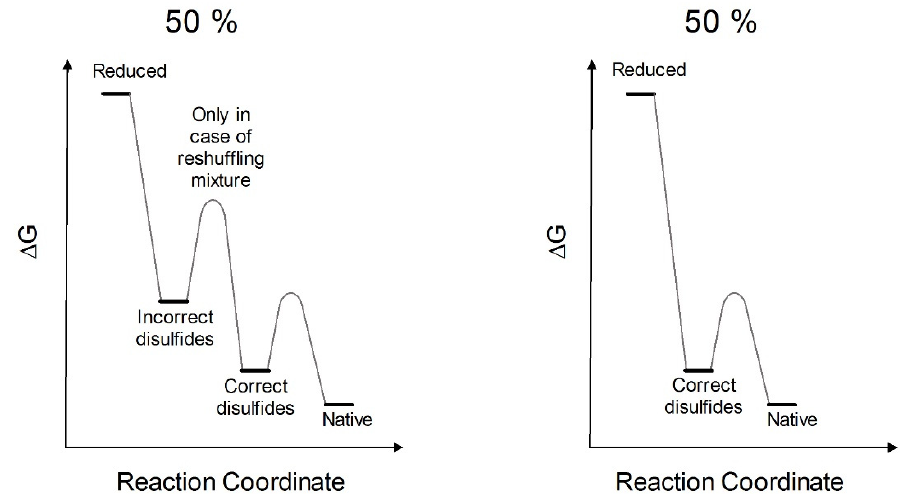
Figure 8. Putative energetic profile of RNase oxidative refolding pathways. From the totally reduced protein to native conformations through kinetic traps (incorrect disulfides) with reshuffling mixture (e.g., GSH/GSSG); without reshuffling mixture, it will not be possible to reach native conformations (left panel). From totally reduced protein to native conformations through intermediates (correct disulfides) (right panel). These schemes derived from the best experimental conditions (described in this study) of reduction and re-oxidation (i.e., rRNase II). The percentage of 50% is referred to the productive conformations that evolved to the native state and is derived from the enzymatic activities as reported in Figure 2B.